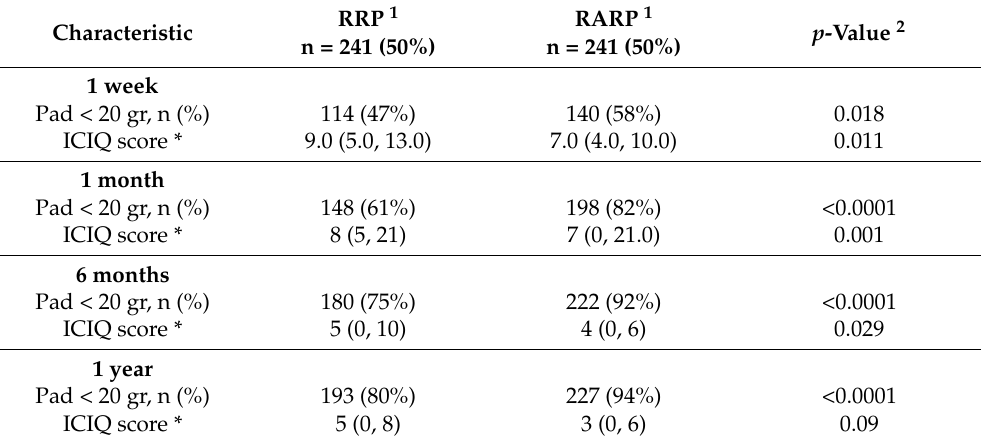
Table 2. Continence recovery rates (pad 0–20 gr) in patients undergoing RRP and RARP at 1 week, 1 month, 6 month, and 1-year follow-up.